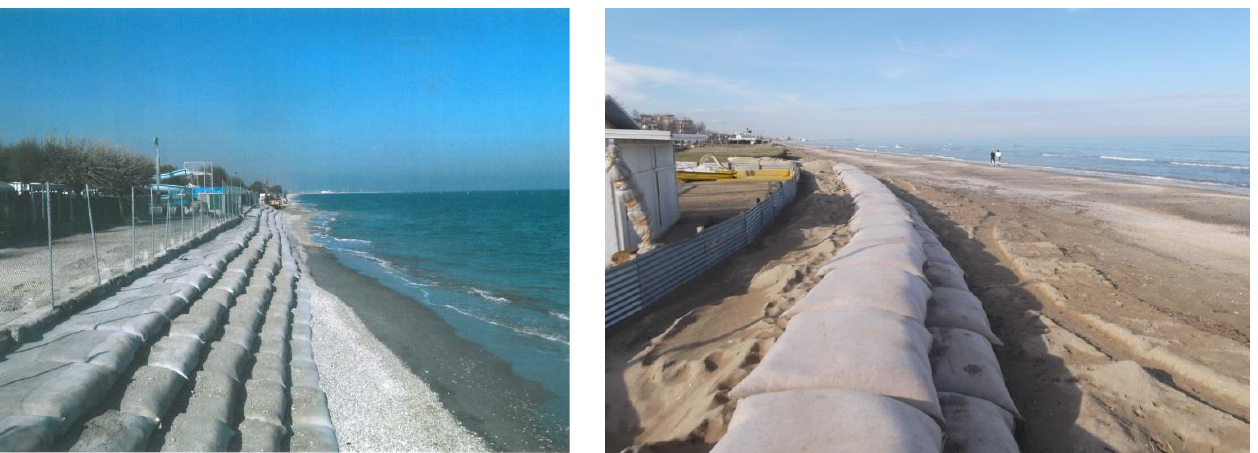
Figure 2. Application of “Stopwave” as temporary groin in Senigallia, Italy ( left panel ) or as pipe- line protection ( right panel ).